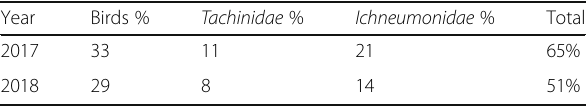
Table 1 Absolute figures of the in the field-associated natural enemies (%) among larval sacs ( n = 400) of A.